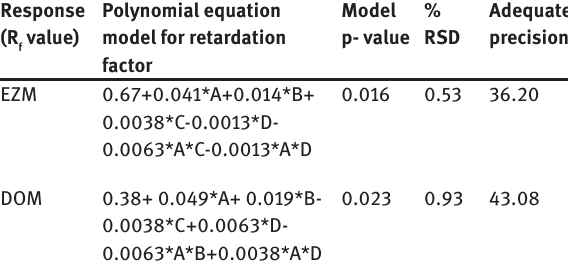
Table 4: Statistical evaluation by ANOVA for predicted response.